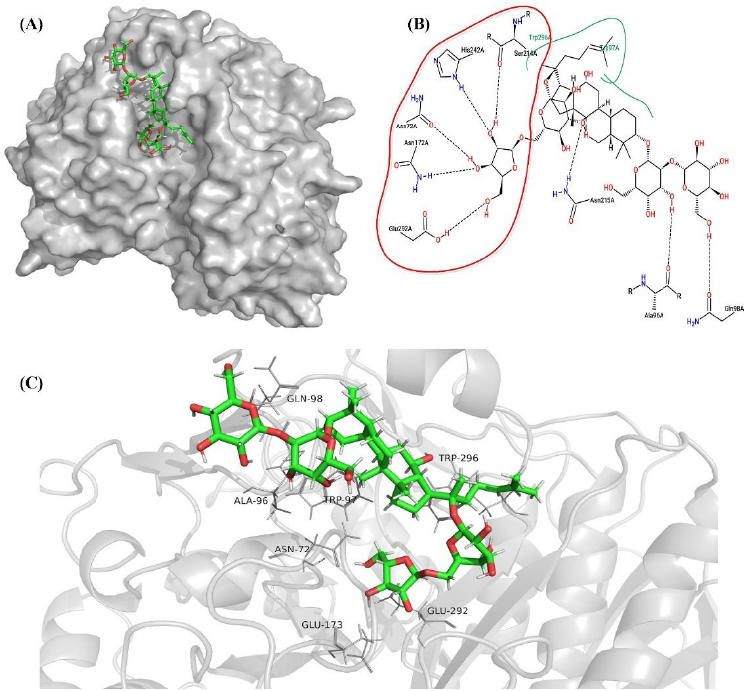
Figure 9. Molecular docking of ginsenoside Rc in the cluster 1 model of BsAbfA (with the minimum docking score). ( A ) Stereoview of the predicted binding of BsAbfA by initial docking. ( B ) Key residues interacting with ginsenoside Rc. ( C ) The binding form and type of key residues with ginsenoside Rc. The dashed line represents hydrogen bonding, and the green line represents hydrophobic interaction.